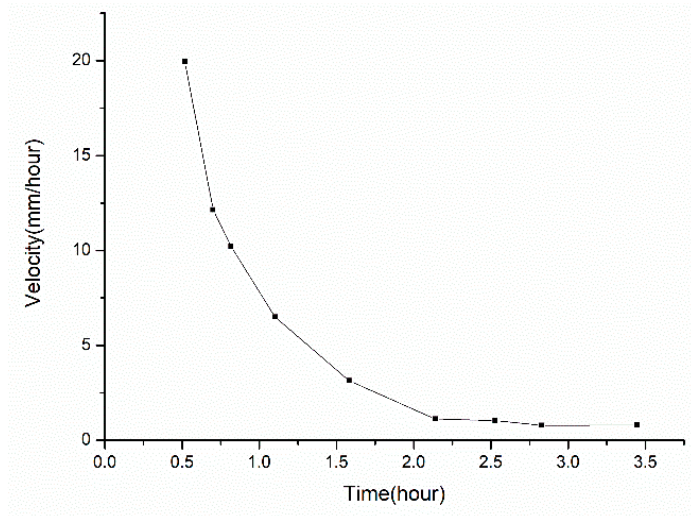
Figure 11. Imbibition velocity of the fracturing fluid versus time for core 57.